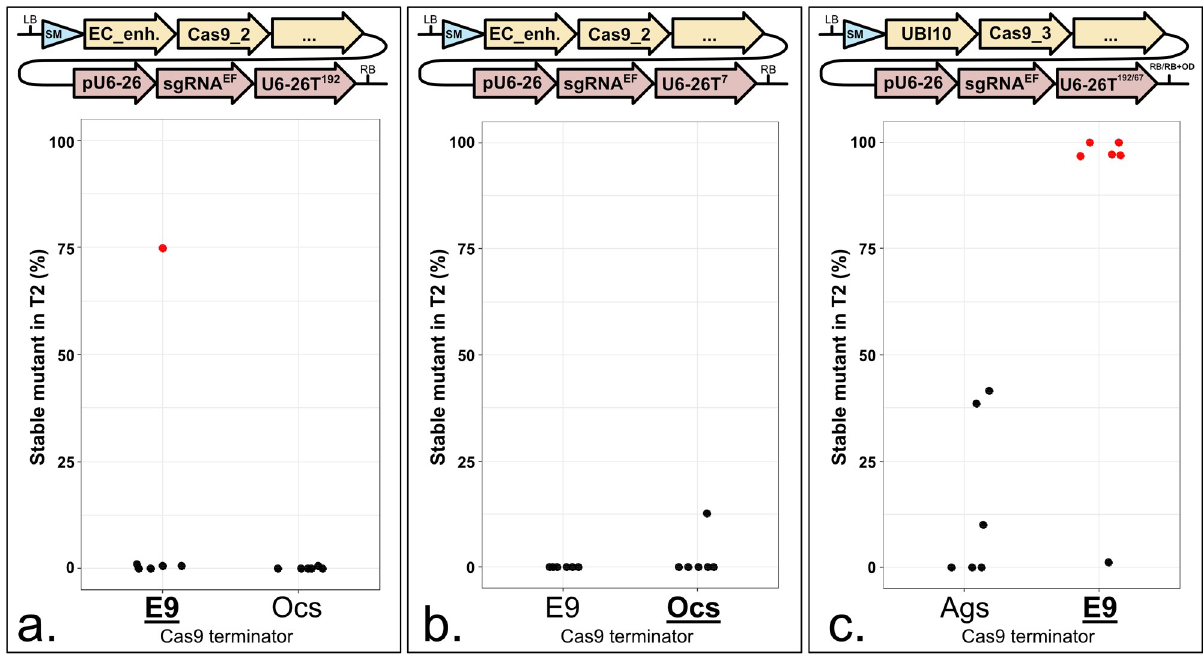
Fig 7. A weak 3’ regulatory sequence reduces the CRISPR-induced mutation rate. a. to c. Each panel represents a terminator comparison in the same context. Terminators can be compared within each panel, not from one panel to another. The modules were assembled into pAGM4723 and transformed into Col-0 via Agrobacterium tumefaciens strain GV3101. LB: Left Border. SM: Selectable Marker ( Glufosinate resistance gene). EC_enh.: 752 bp of the At2g21740 promoter fused to 548 bp of the At1g76750 promoter. UBI10: 1327 bp of the At4g05320 promoter. Cas9_2: Fauser et al ., 2014 [13]. Cas9_3: Li et al ., 2013 [25]. E9T: 631 bp of the Pisum sativum rbcS E9 terminator. OcsT: 714 bp of the Agrobacterium tumefaciens octopine synthase terminator. AgsT: 410 bp of the Agrobacterium tumefaciens agropine synthase terminator. U6-26p: 205 bp of the At3g13855 promoter. sgRNA EF : “extension-flip” sgRNA. U6-26T: 7, 67 or 192 bp of the At3g13855 terminator. RB: Right Border. For the comparison using the UBI10 promoter, the AgsT is in combination with U6-26 192 ; OcsT is in combination with U6-26 67 . The sgRNA targets ADH1 . CRISPR activity measured in % of homozygous or biallelic stable mutants in the second generation after transformation (T2). Each dot represents an independent T2 family. Red dot: All the T2 lines from this family carry the same mutation, indicating a mutation more likely inherited from the T1 parent rather than being de novo from the T2 line. Bold and underlined: Most active construct(s) for each